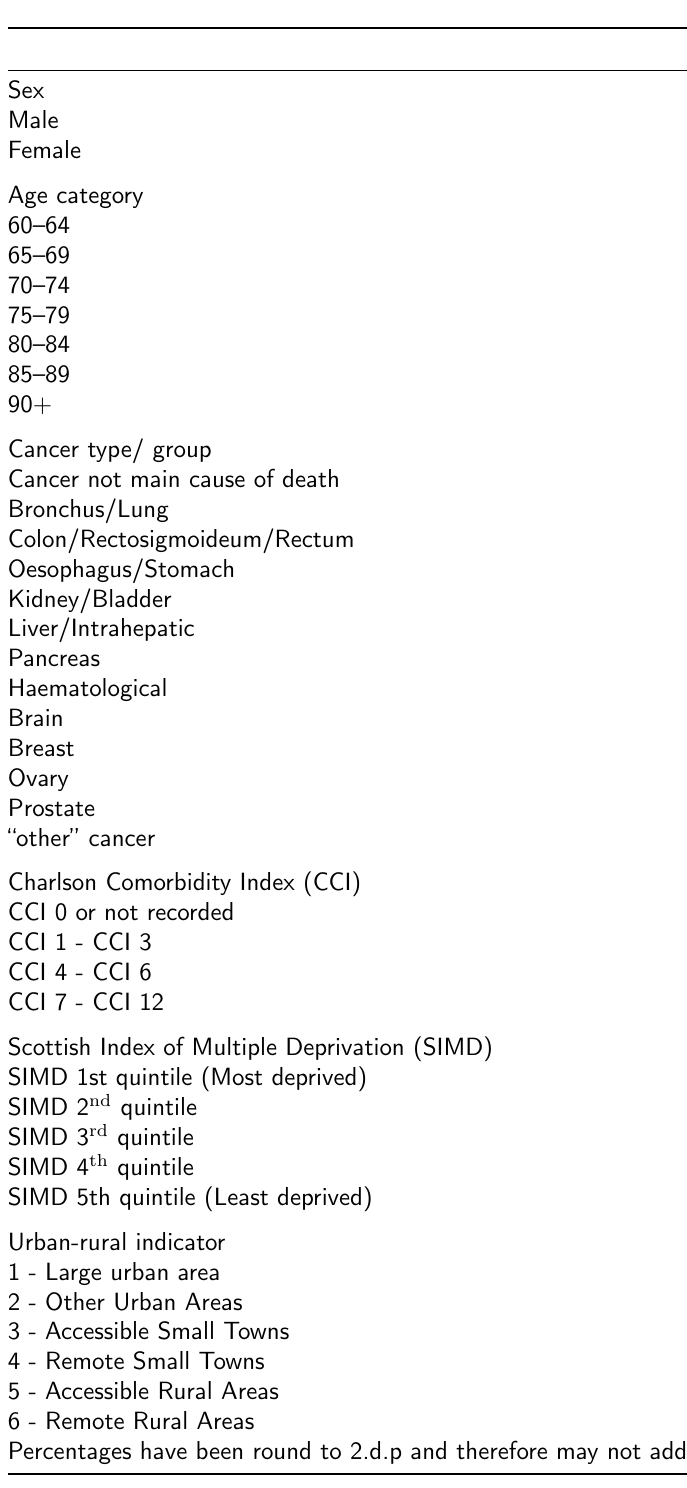
Table 1: Descriptive characteristics of Scottish decedents (2012 to 2017) with a cancer